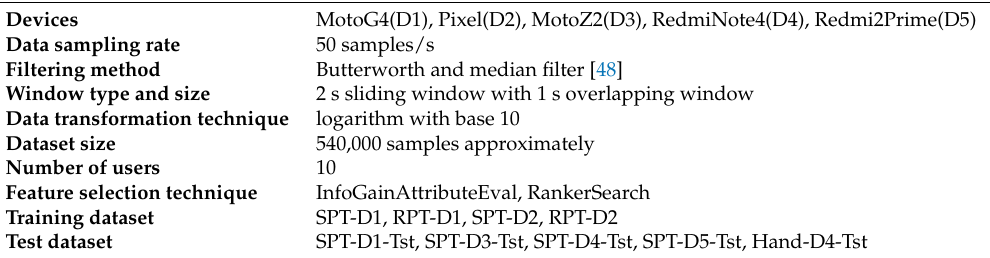
Table 3. Summary of the experimental setup with default values of parameters.